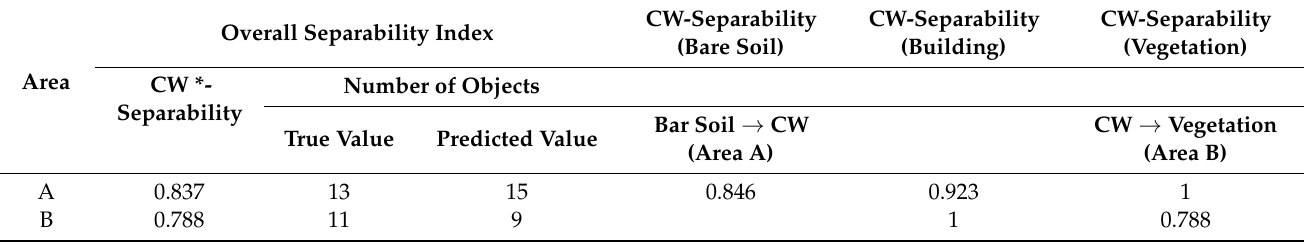
Table 7. Separability evaluation of the construction